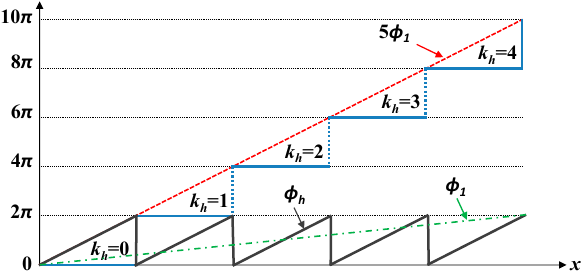
Figure 2. The illustration of high-frequency fringe order determination based on one fringe pattern in multi-frequency temporal phase unwrapping.